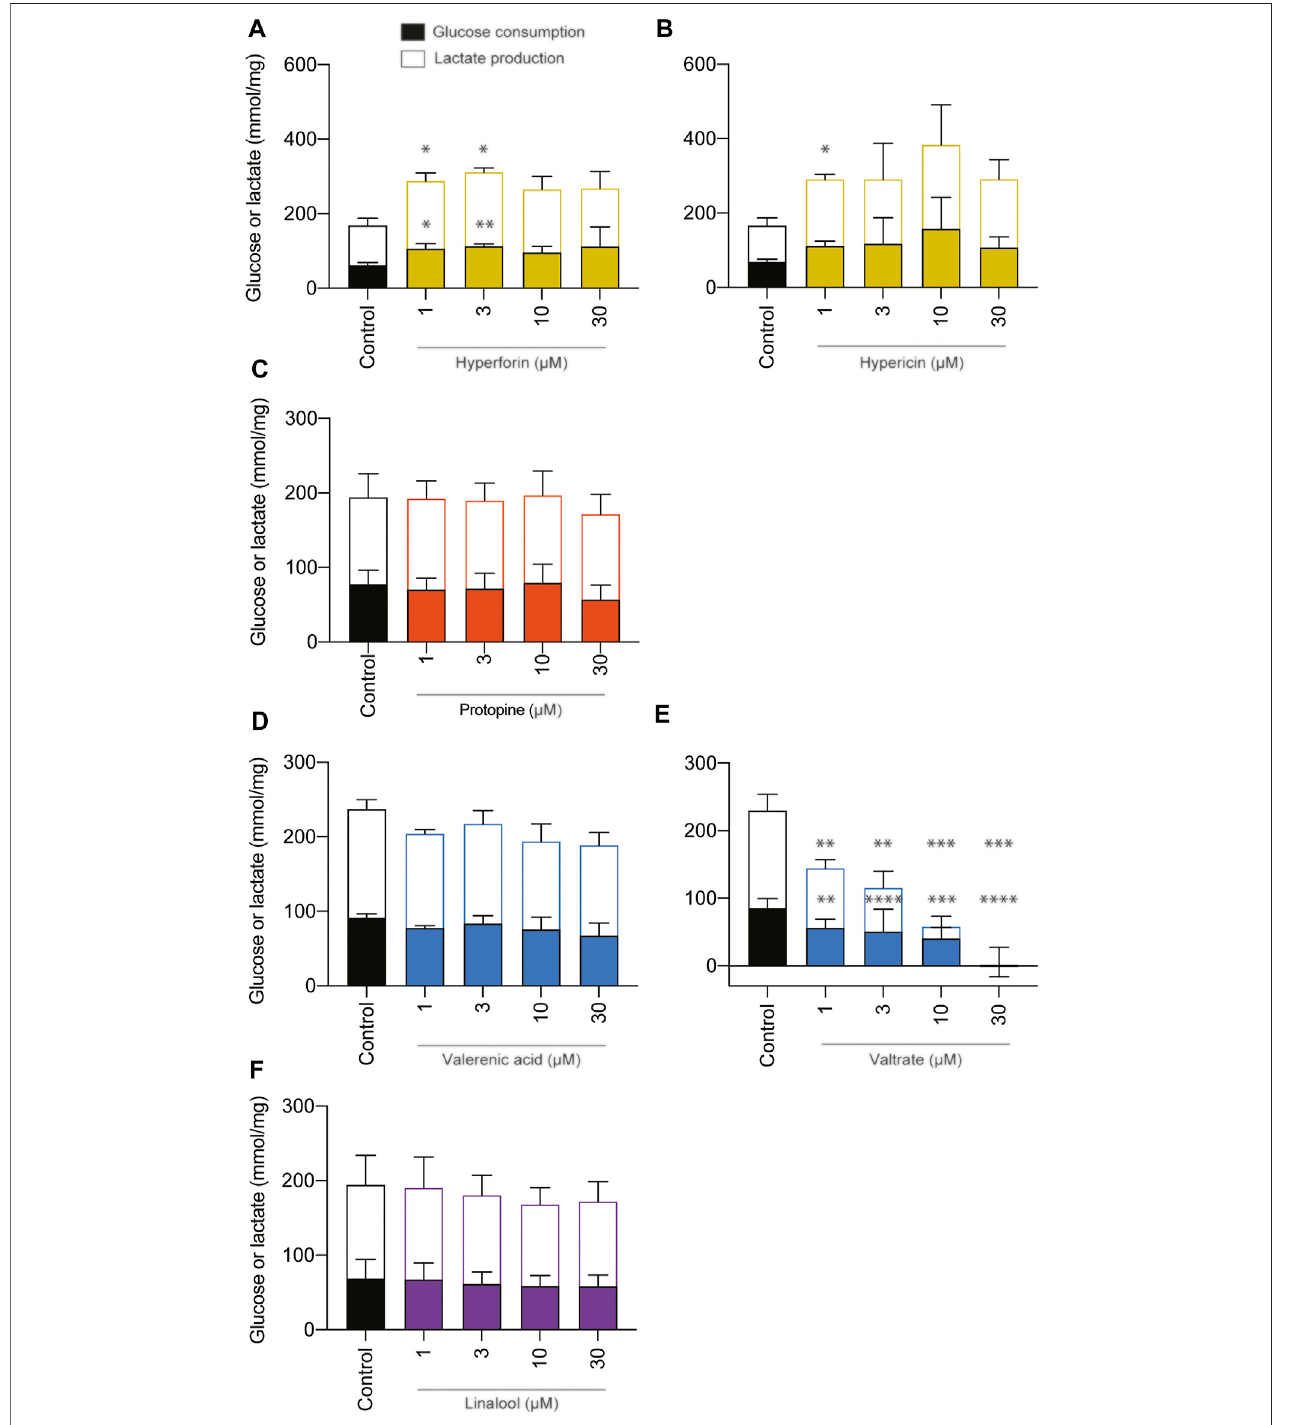
FIGURE 5 | Effects of phytochemicals on glucose consumption and lactate production in undifferentiated BeWo b30 cells after treatment for 48 h. Data were normalized per amount of protein (mg). Control consisted of cell culture media containing 0.2% of DMSO. Data were obtained from three independent experiments ( n = 3;intriplicate)andareshownasmean±SD:* p < 0.05.Astatisticallysigni fi cantimpairmentofmetabolicactivitycouldnotbedetectedatanyofthetestconcentrations(1, 3, 10, and 30 µM) of the following phytochemicals: protopine (C) , valerenic acid (D) , and linalool (F) . However, valtrate (E) decreased the glycolytic metabolism at concentrations of 1, 3, 10, and 30 µM. Phytochemicals of St. John ’ s wort led to increased glucose consumption and concomitant lactate production in the case of hyperforin treatment (A) at 1 and 3 µM and increased lactate concentrations in the case of hypericin (B) at 1 µM.